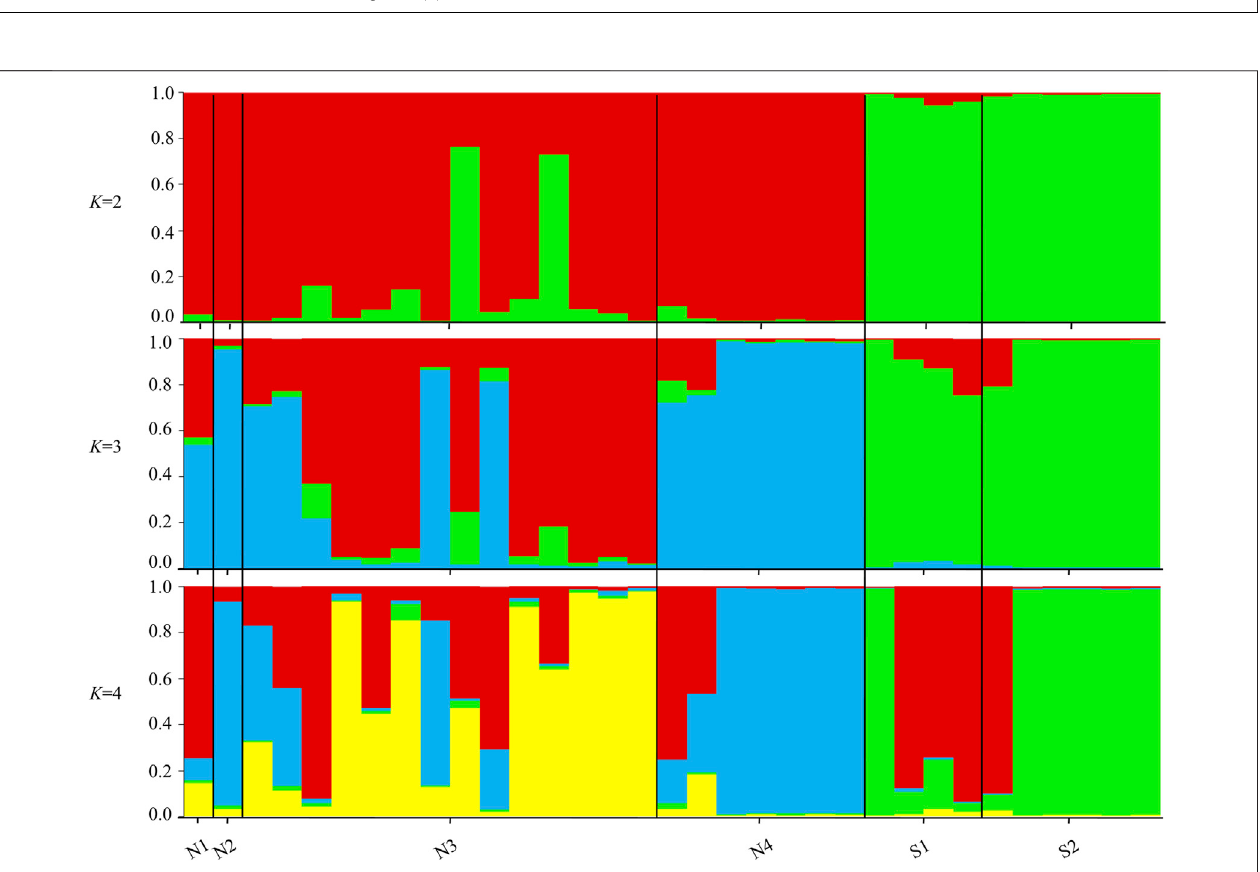
FIGURE3| HistogramsoftheSTRUCTUREassignmenttestforallindividualsat K (cid:1) 2,3,4.Labelsonthex-axisreferencetosamplingsiteandindividual(Northern sites (cid:1) N1, N2, N3, N4 and Southern sites (cid:1) S1, S2). between the northern and southern population groups most genetic variation was found within individuals (91%). ( Table 3 ). AMOVA showed more genetic variation was Genetic differentiation between the northern and southern partitioned between the northern and southern population population groups ( F RT (cid:1) 0.089) was statistically signi fi cant ( p < 0.05), while the genetic differentiation among populations groups (6%) than among populations within groups (3%);